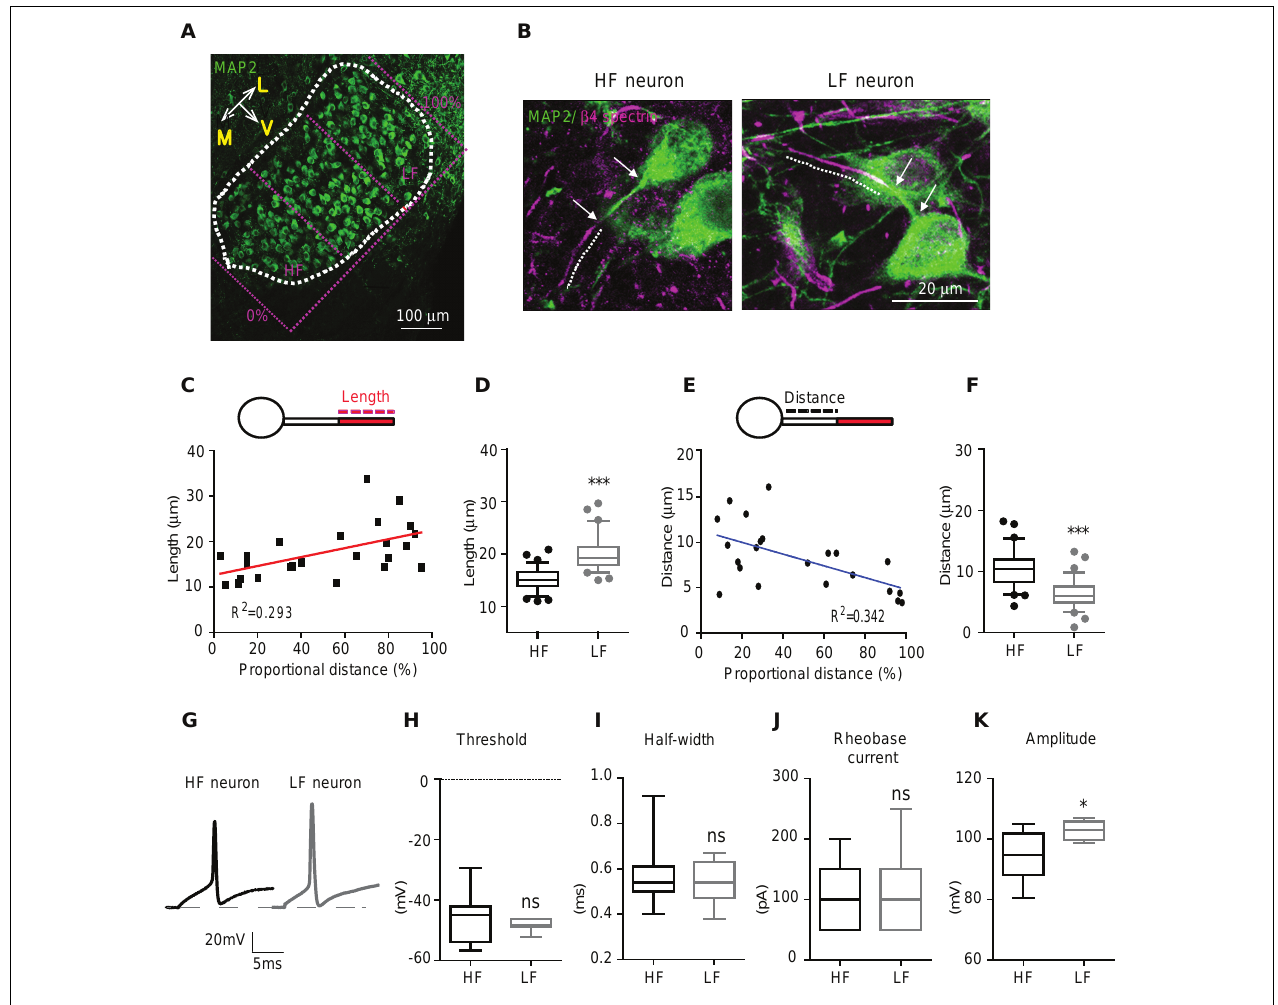
FIGURE 2 | AIS length and position of MNTB neurons depend on their spatial location along the tonotopic axis. (A) Immunostaining of MNTB neurons with MAP2 along the tonotopic axis. The MNTB was proportionally divided by the distance from the medial edge (0%) to the lateral edge (100%). HF neurons were located in < 30%, and LF neurons were located in > 70% of the proportional distance. (B) Representative HF and LF neurons immunostained with MAP2 and β 4 spectrin from normal hearing mice at P20. A dotted line shows AIS length and white arrows point the distance between the AIS and the soma. (C) Plot of AIS length of